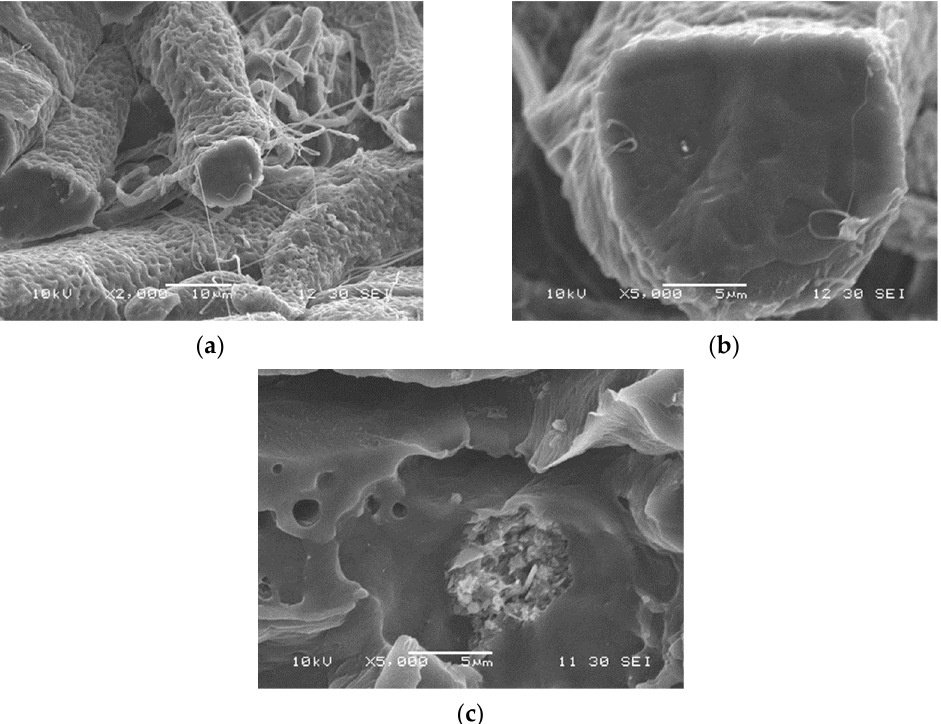
Figure 9. Effect of electrospinning on the distribution of halloysite nanotubes and the structure of the fibers prepared from PCL/halloysite composite materials. Halloysite content and magnification: ( a ) 3 vol%, 2000×; ( b ) 3 vol% 5000×; ( c ) 5 vol%, 5000×.